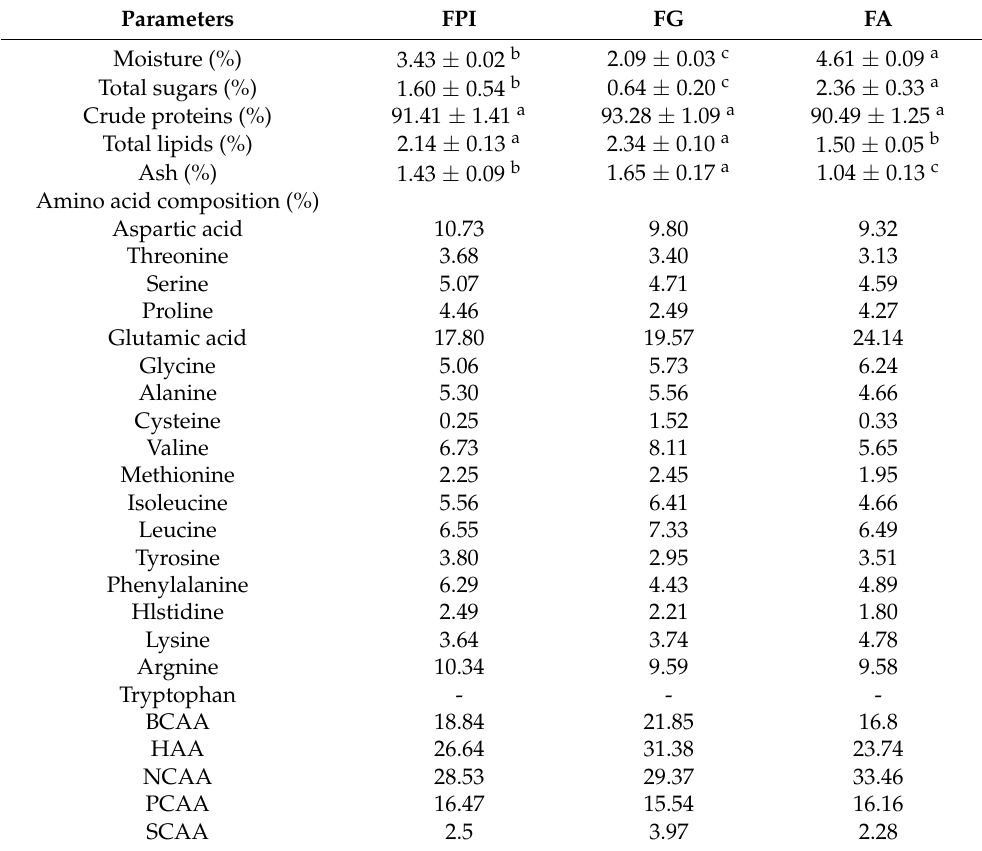
Table 1. The proximate composition of FPI, FG, and